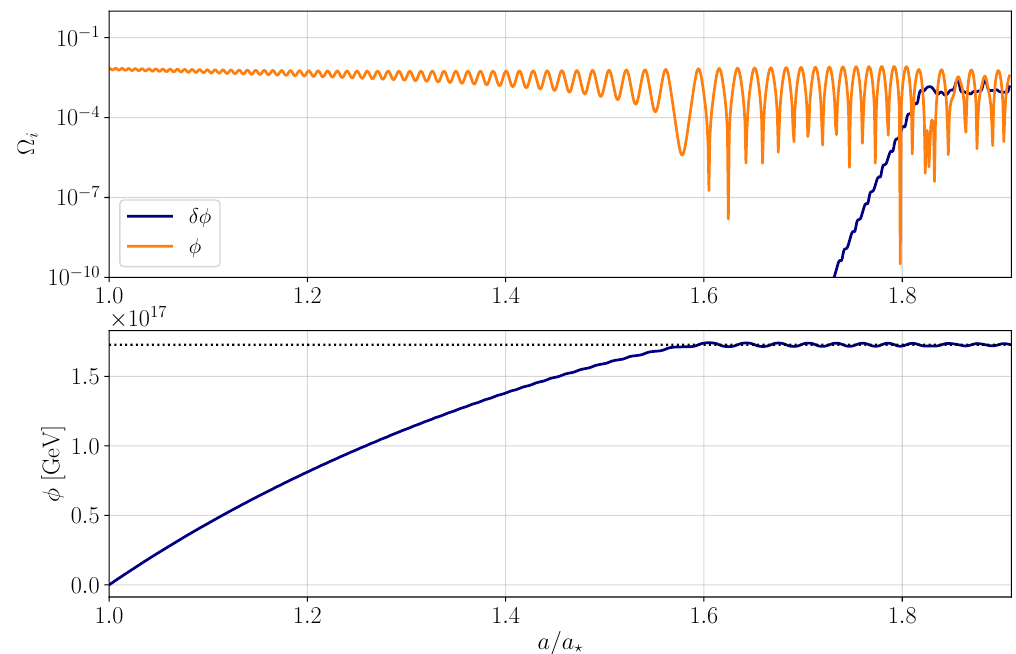
Figure 10: Top: The fractional energy densities of both, the zero mode as well as the excited modes. Note that, in terms of the zero mode, solely the kinetic energy density is depicted. Bottom: Evolution of the zero mode. The ALP rolls over the maximum several times before it gets trapped at the minimum indicated by the black dotted line.